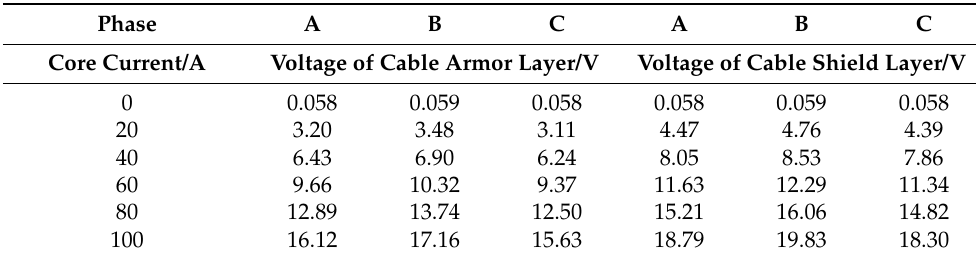
there is no vehicle.